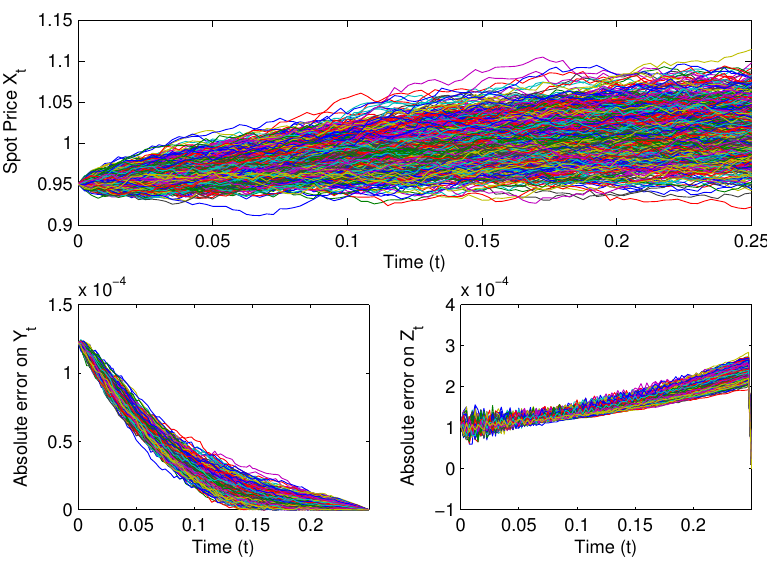
Figure 4. Simulation errors using the 2-stage Runge–Kutta scheme. The numerical solution is obtained on a time mesh with n = 100 time steps and returns an forward price of 1.0121 and initial value of 0.0453 for the control process. The exact values are 1.0123 and 0.0452, respectively.